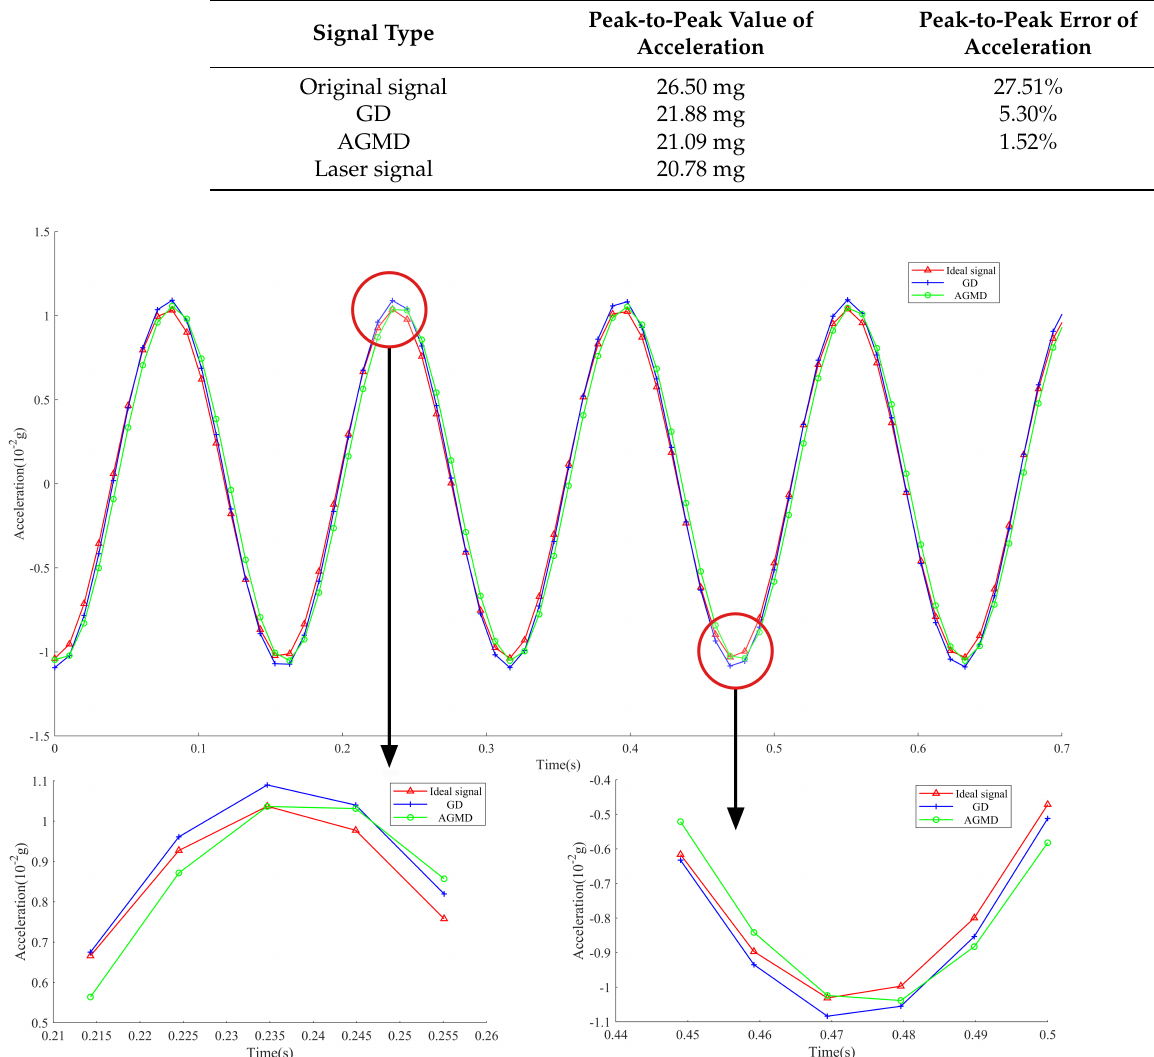
Table 1. Signal comparison results before and after denoising